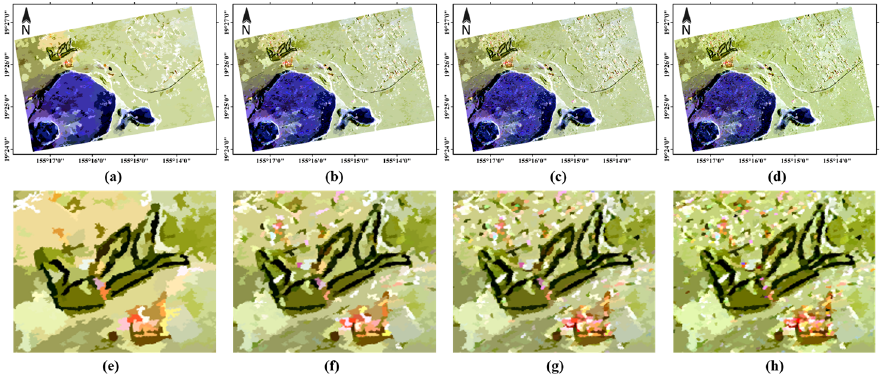
Figure 12. The global and enlarged temporally averaged PauliRGB images with filtered C3 by PIHP method with the pruning factor ( a ), ( e ): P = 1000; ( b ), ( f ): P = 3600; ( c ), ( g ): P = 7200; ( d ), ( h ): P = 10,000.